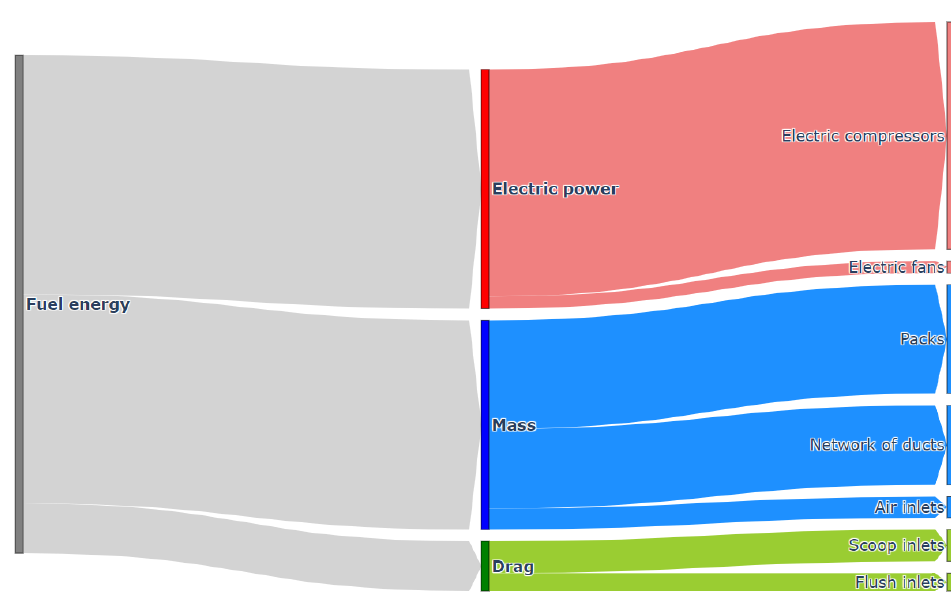
Figure 17. Sankey diagram of the energy consumption induced by the electric